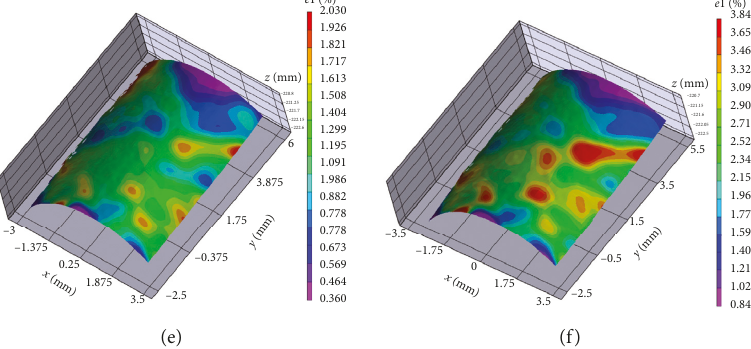
Figure 8: The results of the DIC showing (a) Ti foam made by 52% KCl after 5% deformation, (b) Ti foam made by 52% KCl after 10% deformation, (c) Ti foam made by 52% KCl after 15% deformation, (d) Ti foam made by 17% KCl after 5% deformation, (e) Ti foam made by 17% KCl after 10% deformation, and (f) Ti foam made by 17% KCl after 15%